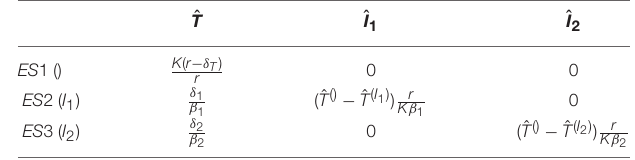
TABLE 3 | The equilibrium states ( ES ) of the basic model with homeostatic target cell dynamics.